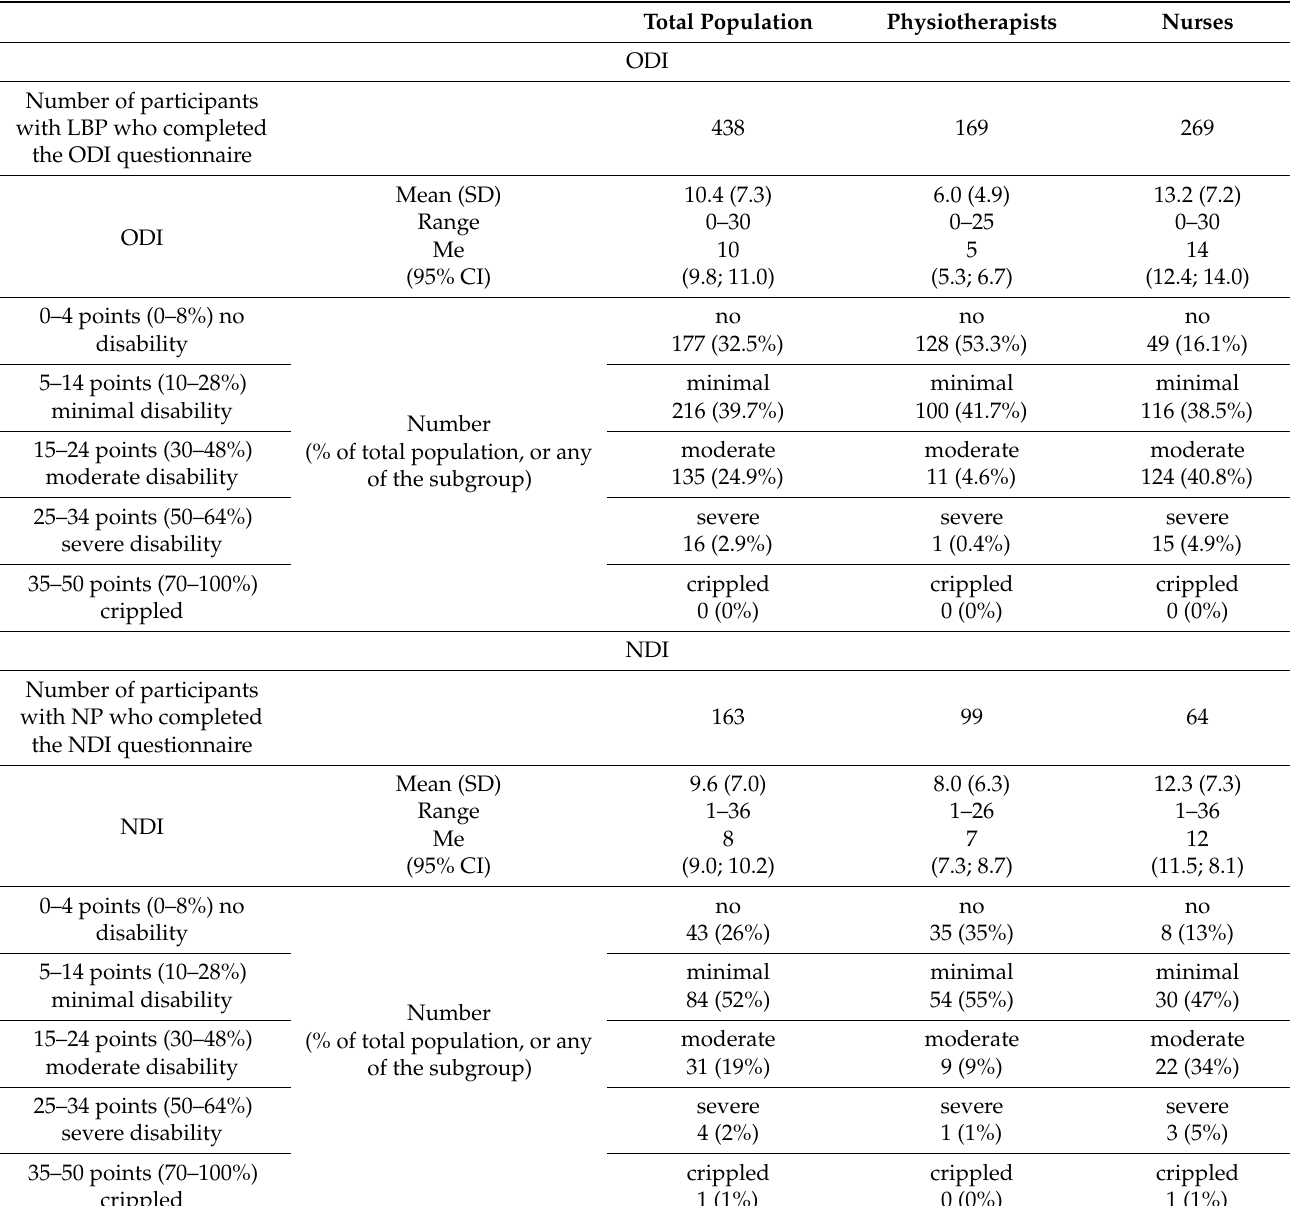
Table 5. ODI and NDI scores in physiotherapists and